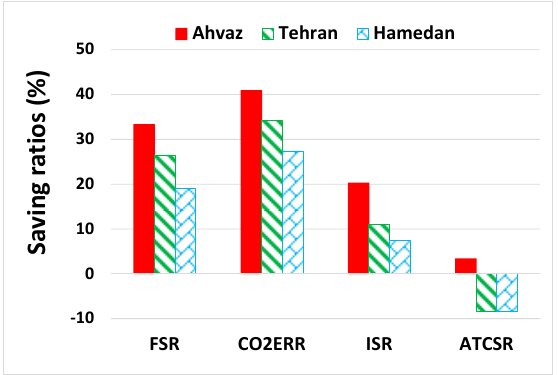
Figure 8. Fuel saving ratio ( FSR ), CO 2 emission reduction ratio ( CO2ERR ), annualized total cost saving ratio ( ATCSR ), and integrated savings ratio ( ISR ) in Ahvaz, Tehran, and Hamedan.